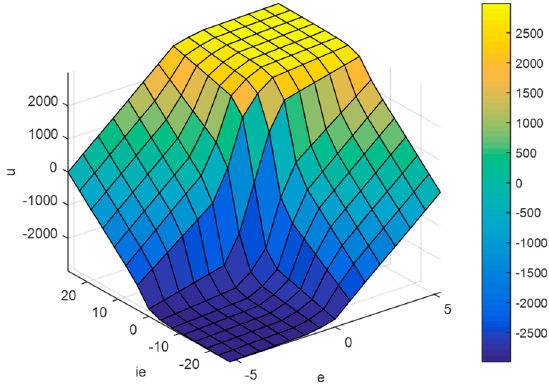
Figure 10. Membership functions for fuzzy variables: ( a ) e ( t ) ; ( b )